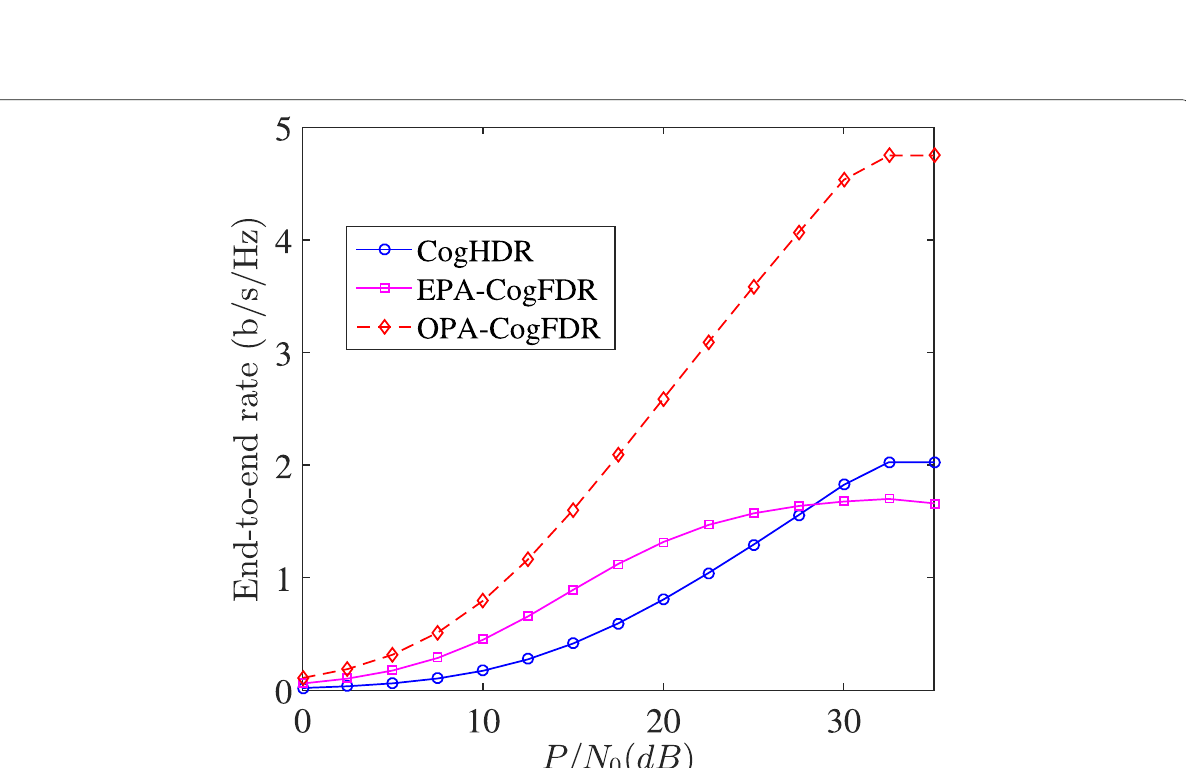
Fig. 14 End-to-end rate instantaneous comparison with effect of interference from PT; P PT / N 0 = 10